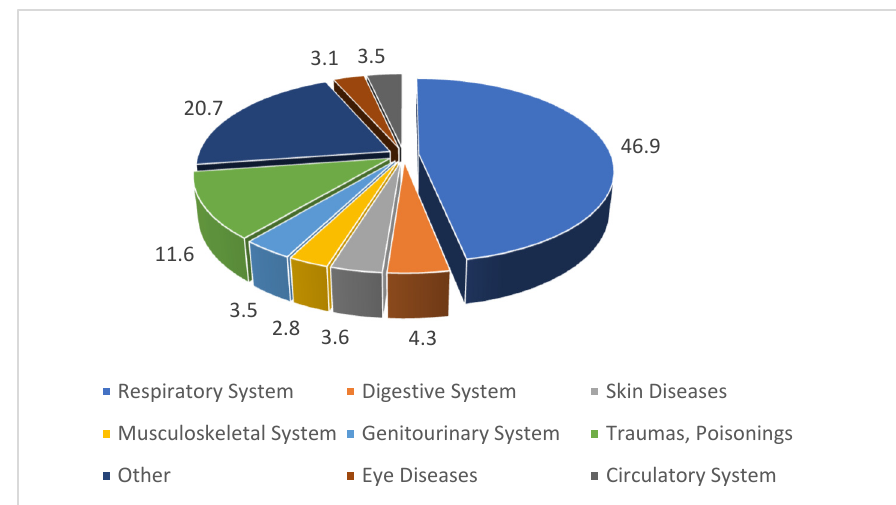
Figure 4. Structure of morbidity in Ulan-Ude in 2020, %. Respiratory diseases account for the largest share of the total morbidity rate in Ulan- Ude and Buryatia, both for 2020 and over a multi-year period. The morbidity of the population of Ulan-Ude during the period from 2011 to 2020 has increased for respiratory diseases by 11.5%, and by 8.35% for diseases of the circulatory system (Table 6). To establish the correlation between air pollution and the growth of morbidity in Ulan-Ude, a correlation analysis was carried out with a small number of observations (n=10 years). To assess the strength of the correlation, we used the generally accepted cri- teria: correlation coefficient r xy < 0.3 indicates a weak correlation, 0.3 ≤ r xy < 0.7—average correlation, and 0.7 ≤ r xy —very high correlation. The correlation reliability criterion was calculated as follows: t r = r xy /m r , where m r is the mean error. A correlation is considered reliable if t r ≥ 3. Table 6. Dynamics of population morbidity in Ulan-Ude for 2011–2020 (cases per 100,000 popula- tion).